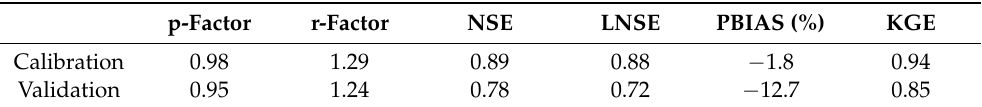
Figure 2. ( a ) Average precipitation, observed (Qobs) and simulated (Qsim) monthly streamflow, and uncertainty band; ( b ) scatter plots of the observed and simulated monthly streamflow from January 2004 to December 2018. Table 4. Results of uncertainty and performance analysis of SWAT for the calibration and validation with OP and CRU climate data.